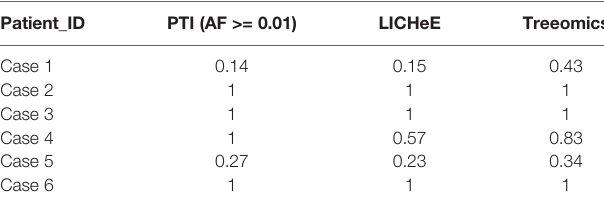
TABLE 1 | The comparison of PTI, LICHeE, and Treeomics based on HGSC data